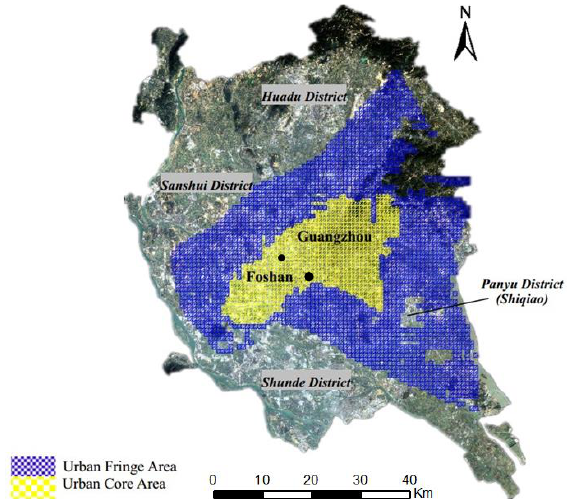
Figure 6. Final delineation of the urban fringe area.